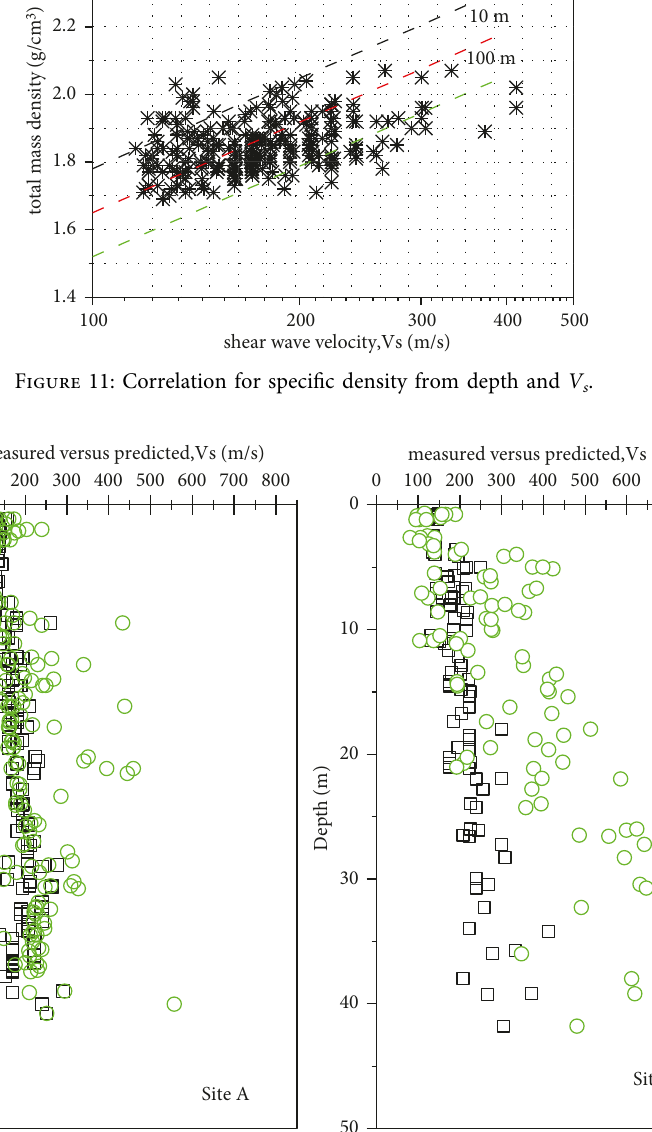
Figure 12: Measured versus predicted shear wave velocities at Sites A and